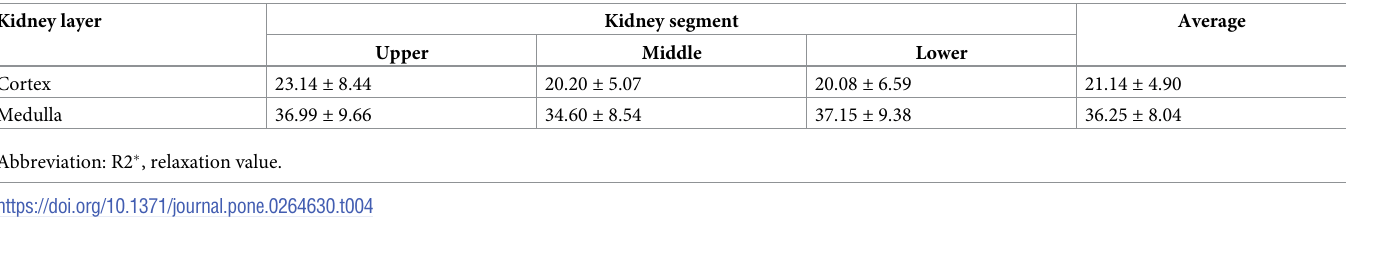
Table 4. R2 � values for the renal artery stenosis